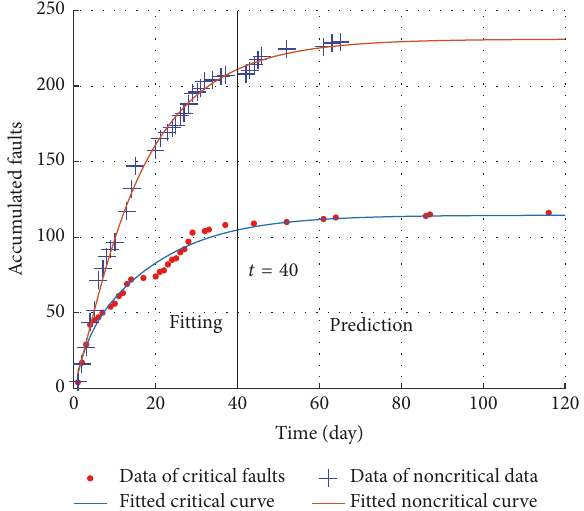
Figure 8: Fitted curves of the critical and noncritical faults.